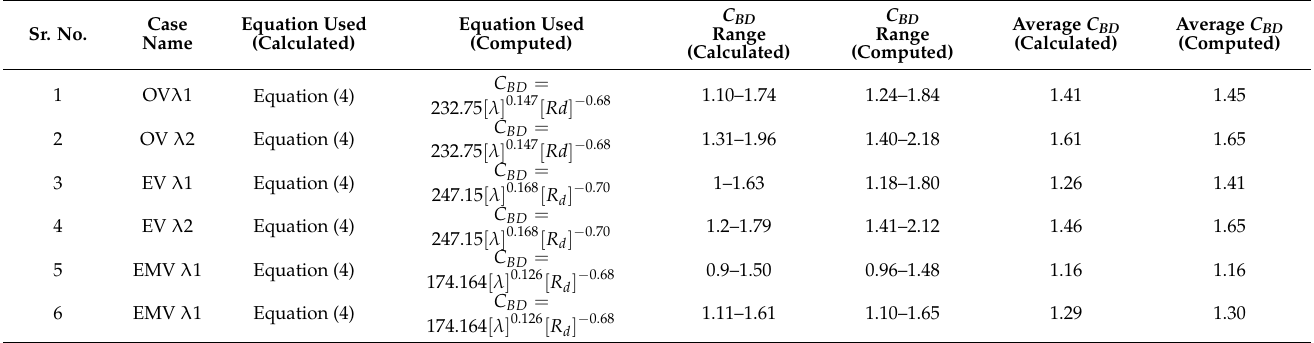
Table 3. Presentation of the hydraulic parameters for the conducted experiments.